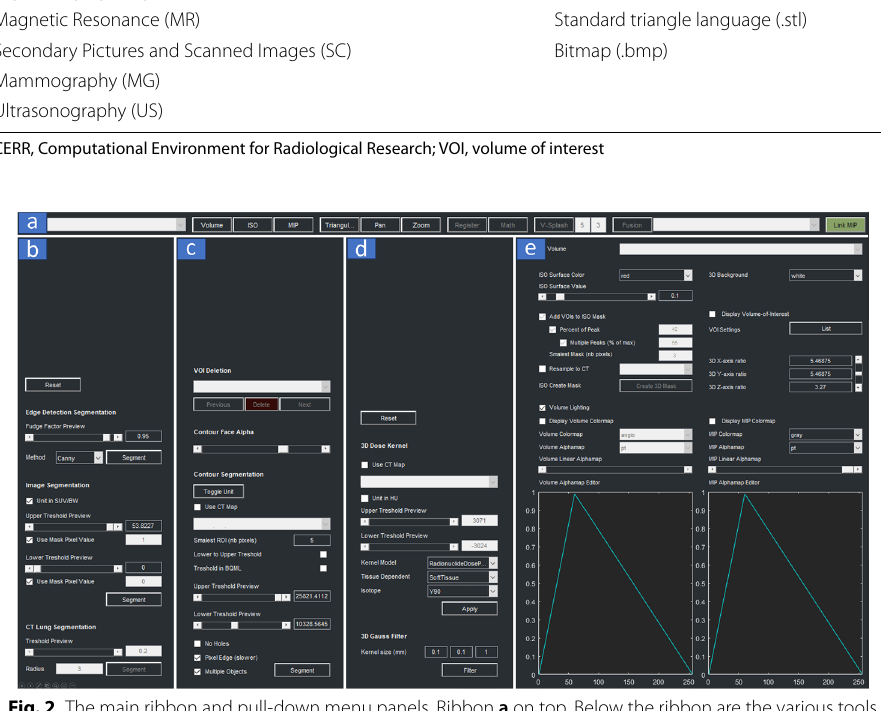
Fig. 2 The main ribbon and pull-down menu panels. Ribbon a on top. Below the ribbon are the various tools from left to right: b image editing, c contour segmentation, d kernel, and e the three-dimensional